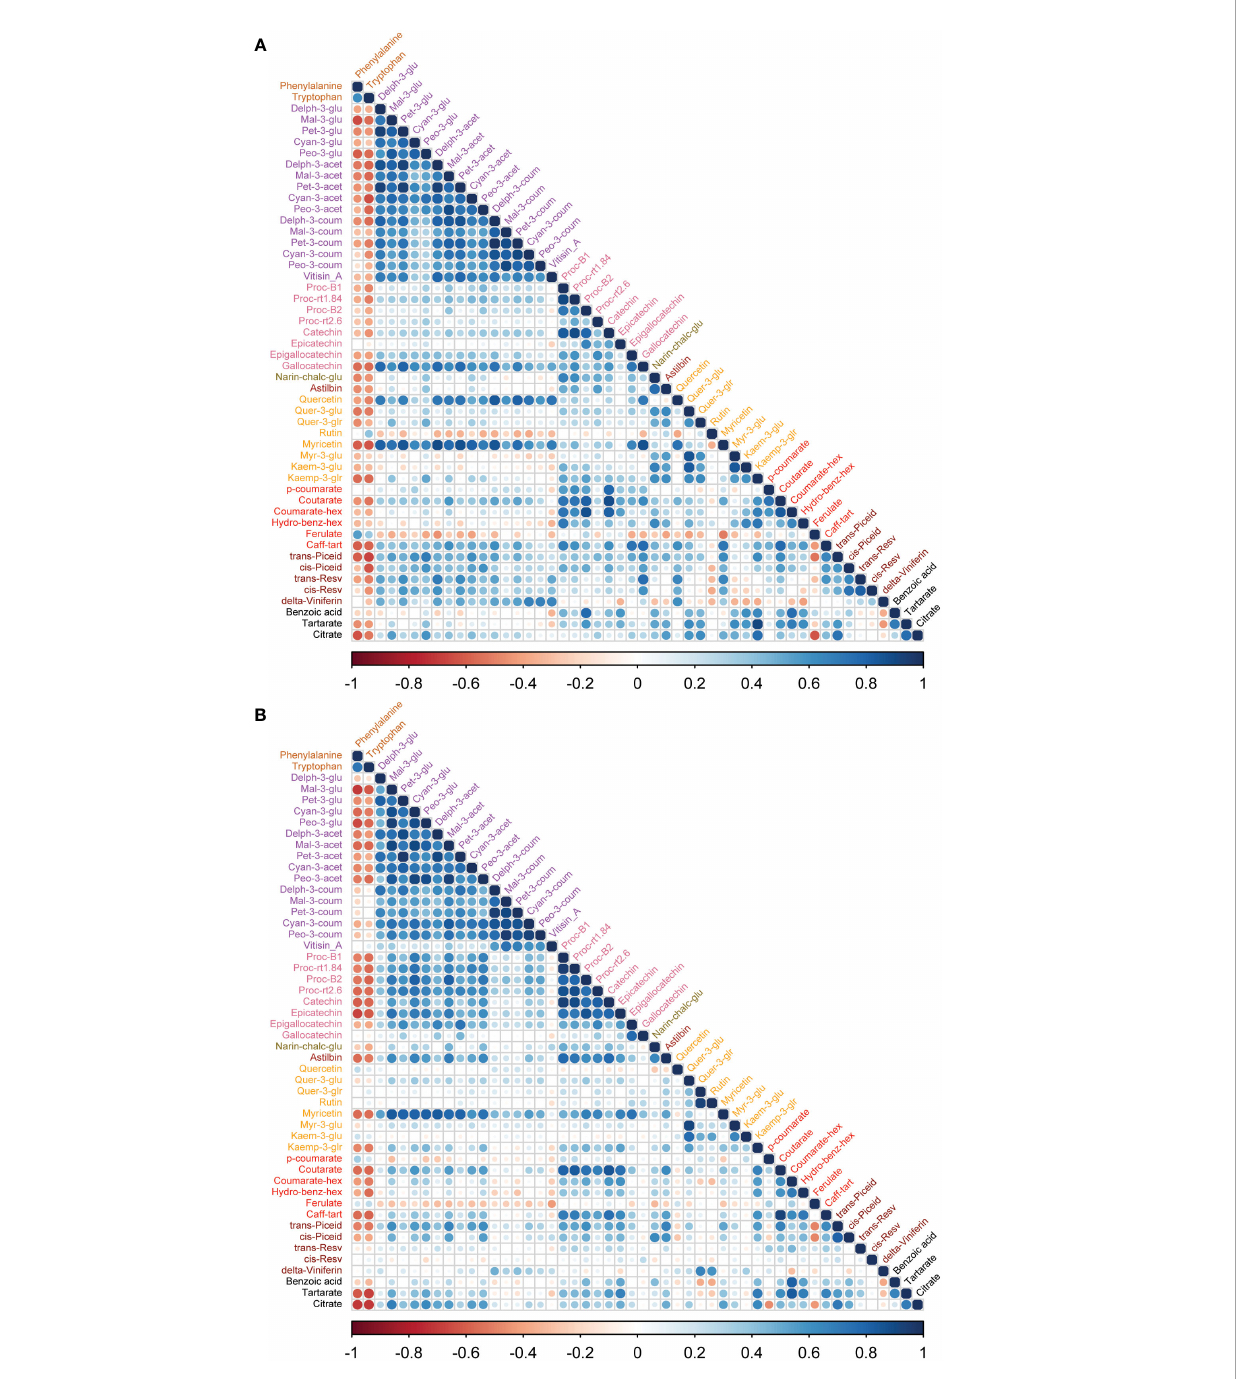
FIGURE 4 Correlation analyses between metabolites of two cultivars (A) Syrah must, most of the metabolites were positively correlated except rutin, myr-3-glu, kaem-3-glu, hydro-benz-hex, ferulate and benzoic acid which were negatively correlated. (B) Malbec must, most of the metabolites were positively correlated except p-coumarate, ferulate and cis-resv were negatively correlated with other metabolites. Amino acids were negatively correlated with most of the metabolites except rutin, ferulate in Syrah must, while quercetin, kaem-3-glu, p-coumarate and ferulate showed a positive correlation with amino acids. Vitisin_A was negatively correlated with most other metabolite